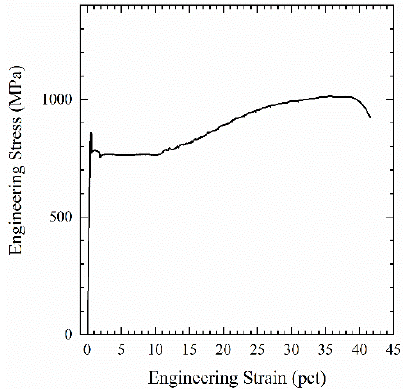
Figure 2. Room temperature, quasi-staticengineering stress-strain curve for the industrially batch annealed (primary soaked) material.